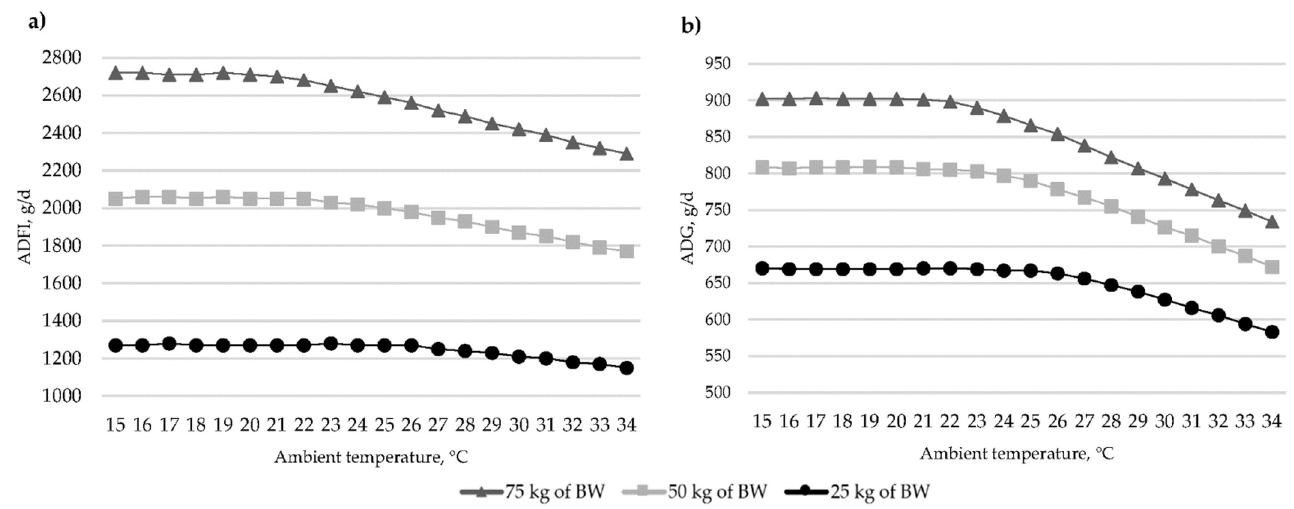
Figure 6. The effects of ambient temperature and pig BW on ( a ) ADFI and ( b ) ADG (Renaudeau et al. [63]).